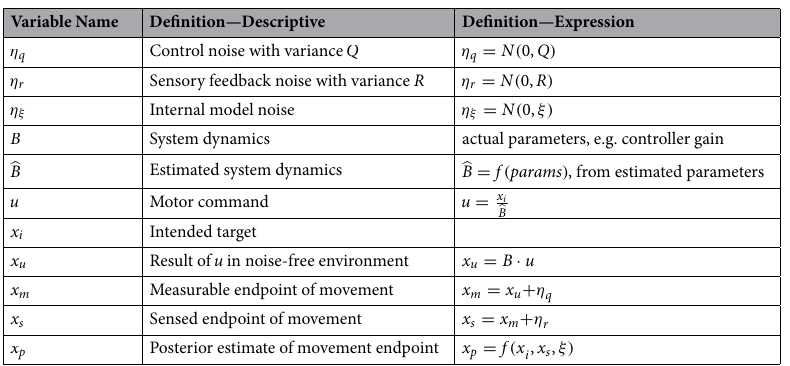
Table 1. Summary of variable definitions.